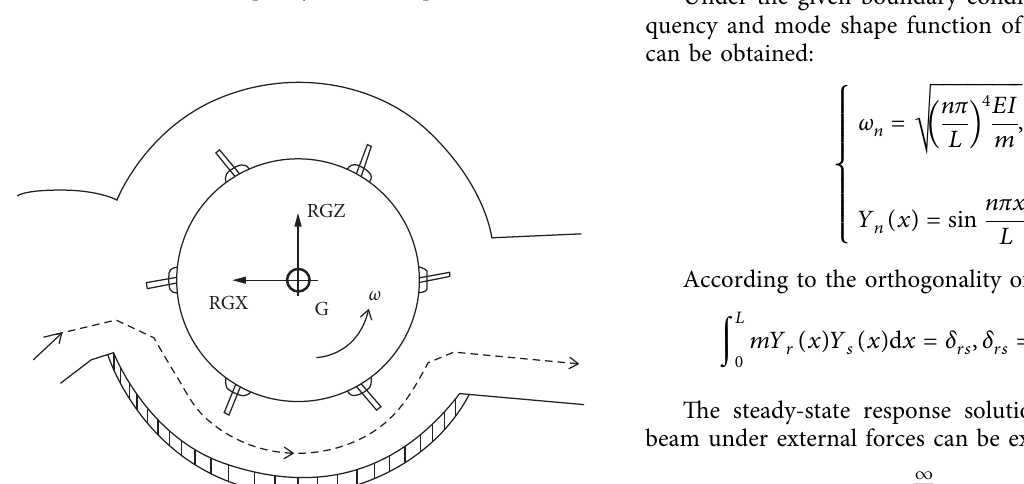
Figure 5: Frequency-domain response.